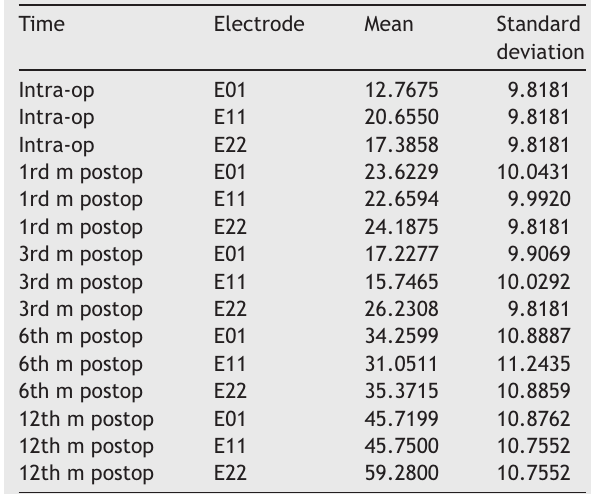
Mean and standard deviation for each combination of time and electrode in the measurement of the amplitude of N1-P1 waves ( (cid:2) V).